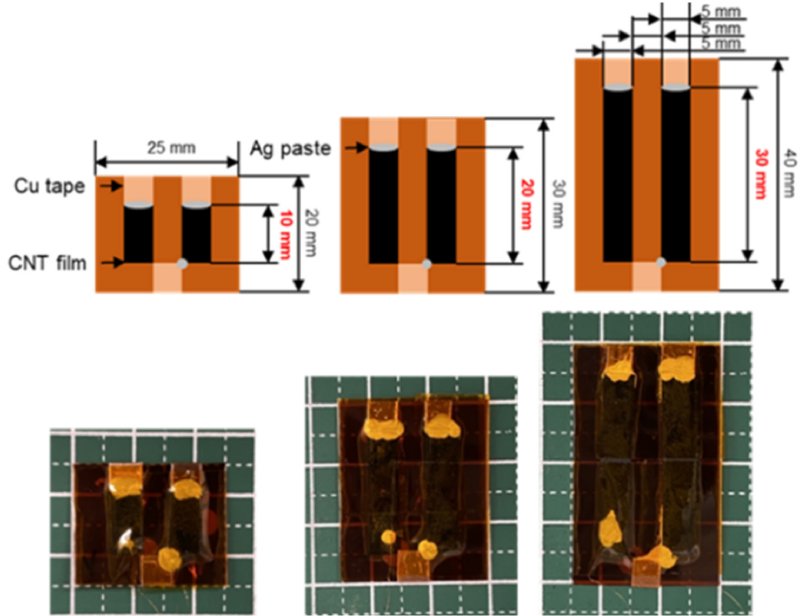
Figure 2. Detailed dimensions of the DFTEGs and photographs of the completed DFTEGs.